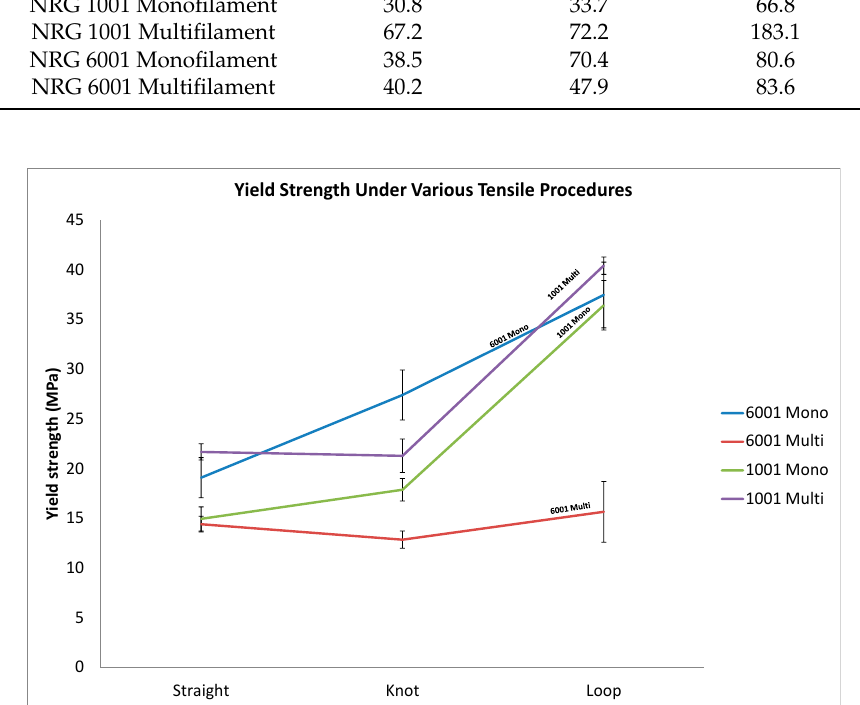
Figure 12. Yield strength from tensile analysis of the multifilament and monofilament fibres.